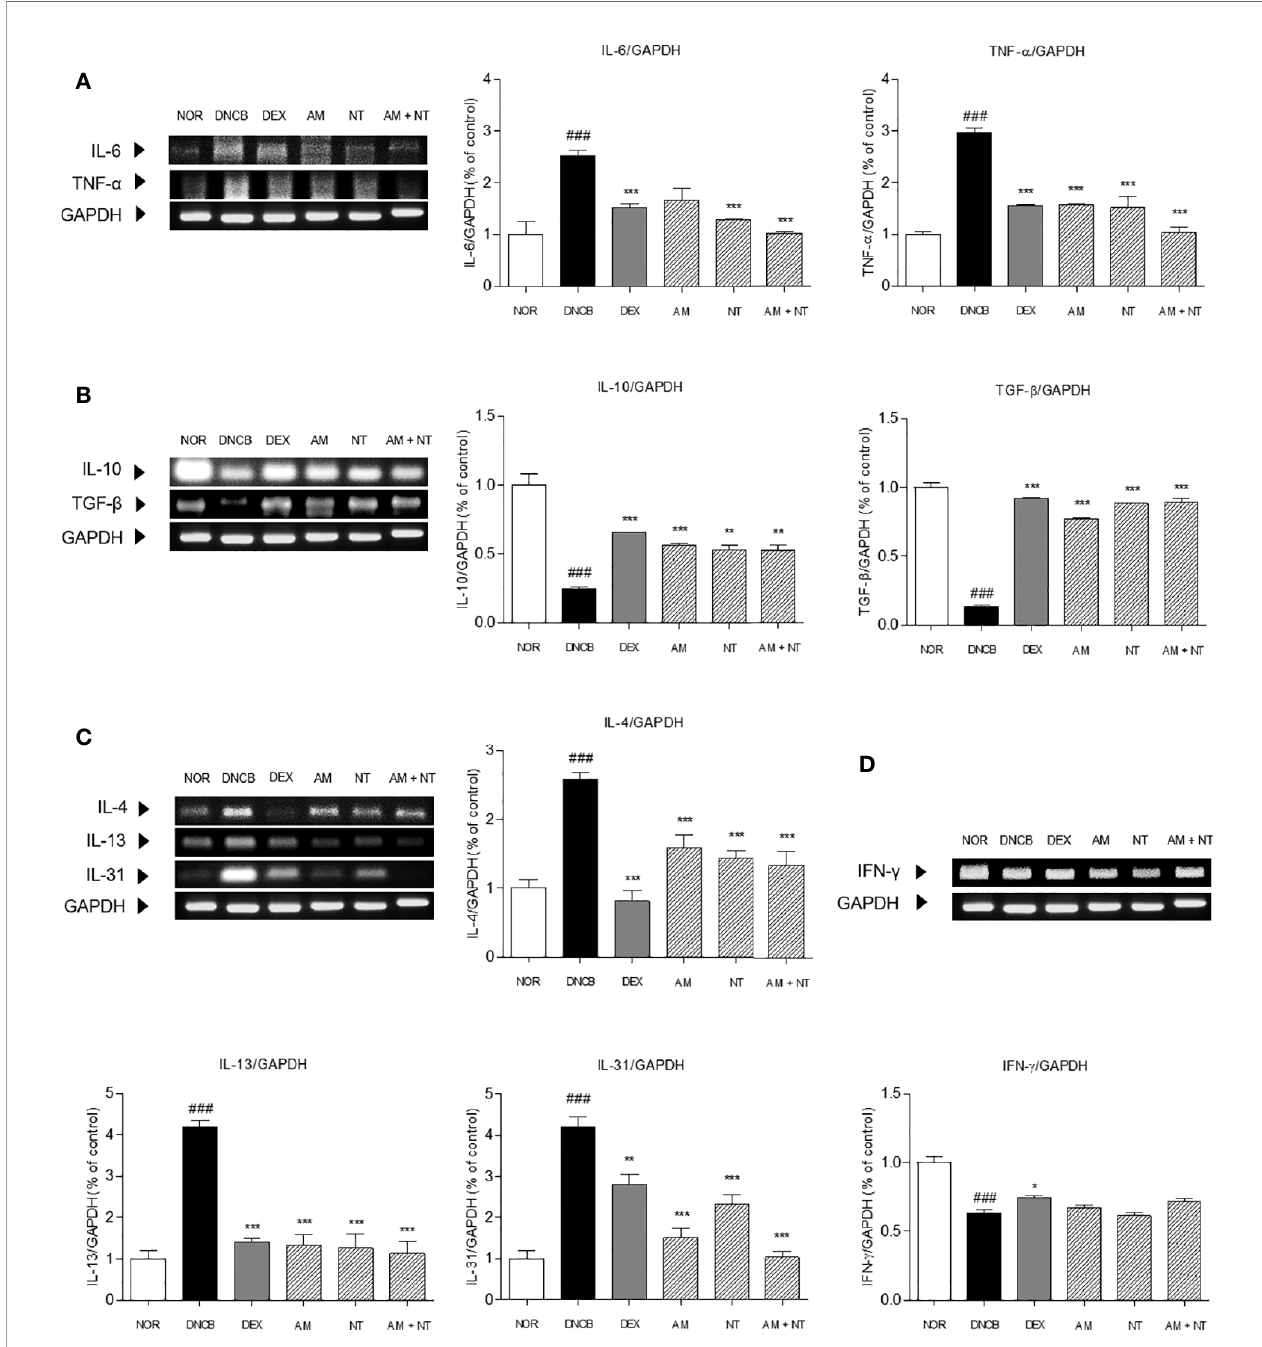
FIGURE 5 | Effects of AM, NT, and a mixture of AM and NT on in fl ammatory cytokine levels: (A) pro-in fl ammatory cytokines; interleukin (IL)-6 and TNF- a , (B) anti- in fl ammatory cytokines; IL-10 and TGF- b , (C) Th2 speci fi c cytokines; IL-4, -13, and -31; and (D) Th1 speci fi c cytokines; IFN- g in mice with allergic contact dermatitis skin lesions. Data were presented as means ± S.E.M (n = 5). ### p < 0.001 vs. NOR; * p < 0.05, ** p < 0.01, and *** p < 0.001 vs.